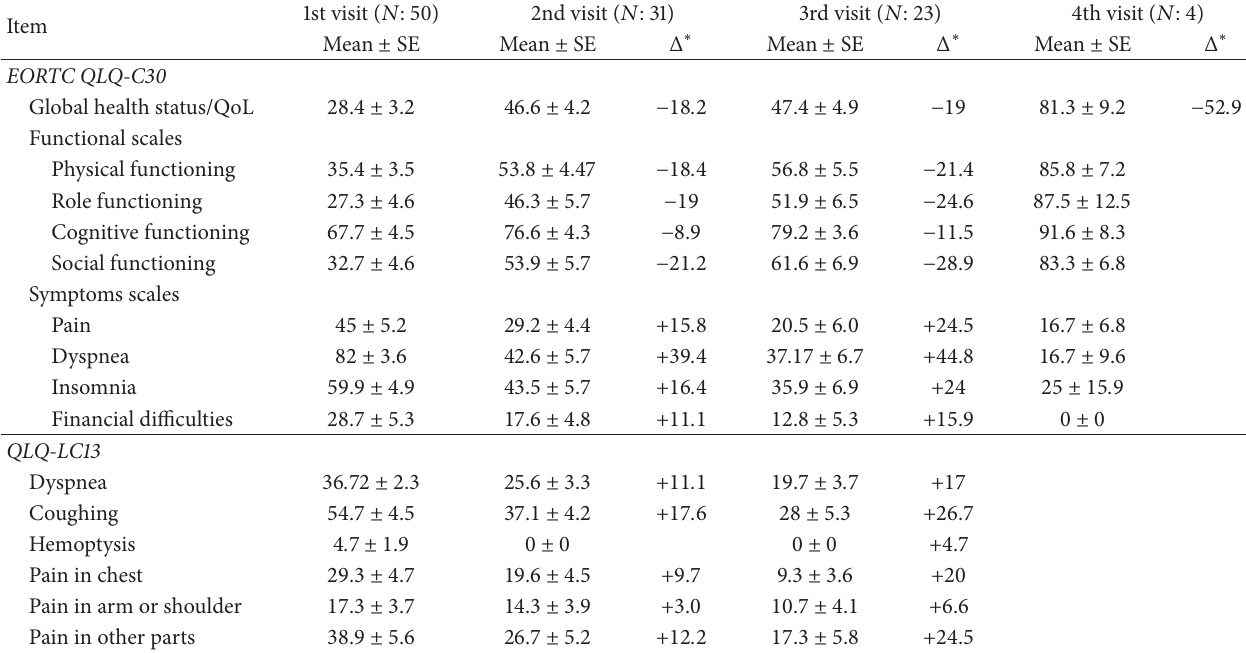
Table 2: Quality of life domains in different visits.